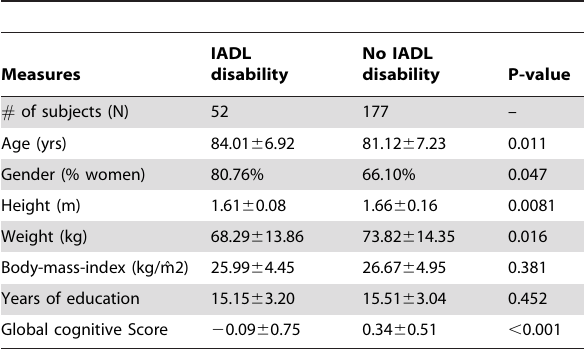
Table 1. Characteristics of subjects with and without IADL